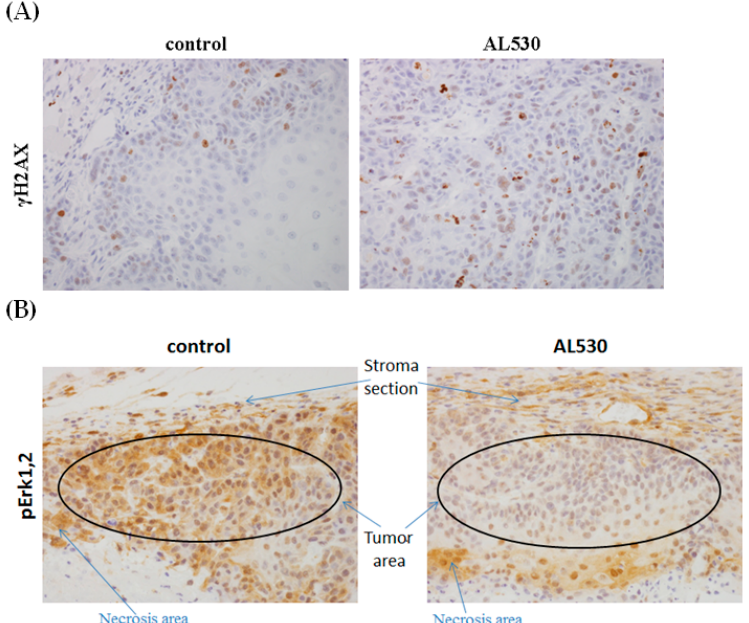
Figure 5. Immunohistochemistry analysis of the effect of AL530 on tumor tissue. Thick sections of 4 µm formalin fixed and paraffin embedded in tumors from CAL33 cell xenografts in nude mice treated with vehicle or 50 mg/kg of AL530 i.p. for 13 days, were stained with antibody against γ -H2AX ( A ) and pErk1,2 ( B ) (magnification, x20).